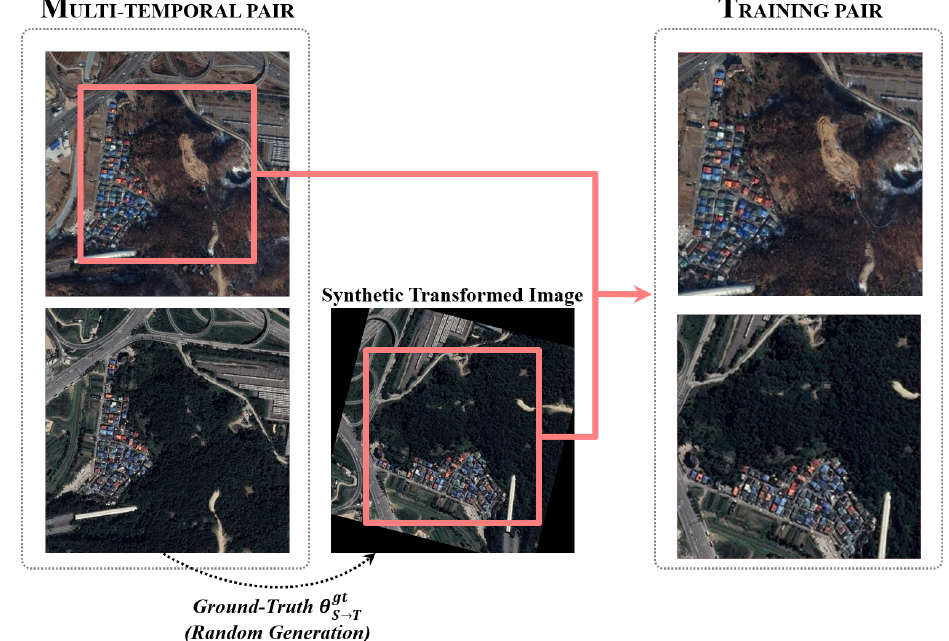
Figure 8. Process of generating the training pairs. In the training procedure, given a multi-temporal aerial image pair, we perform the transformation on the second image using the ground-truth θ gt which is randomly